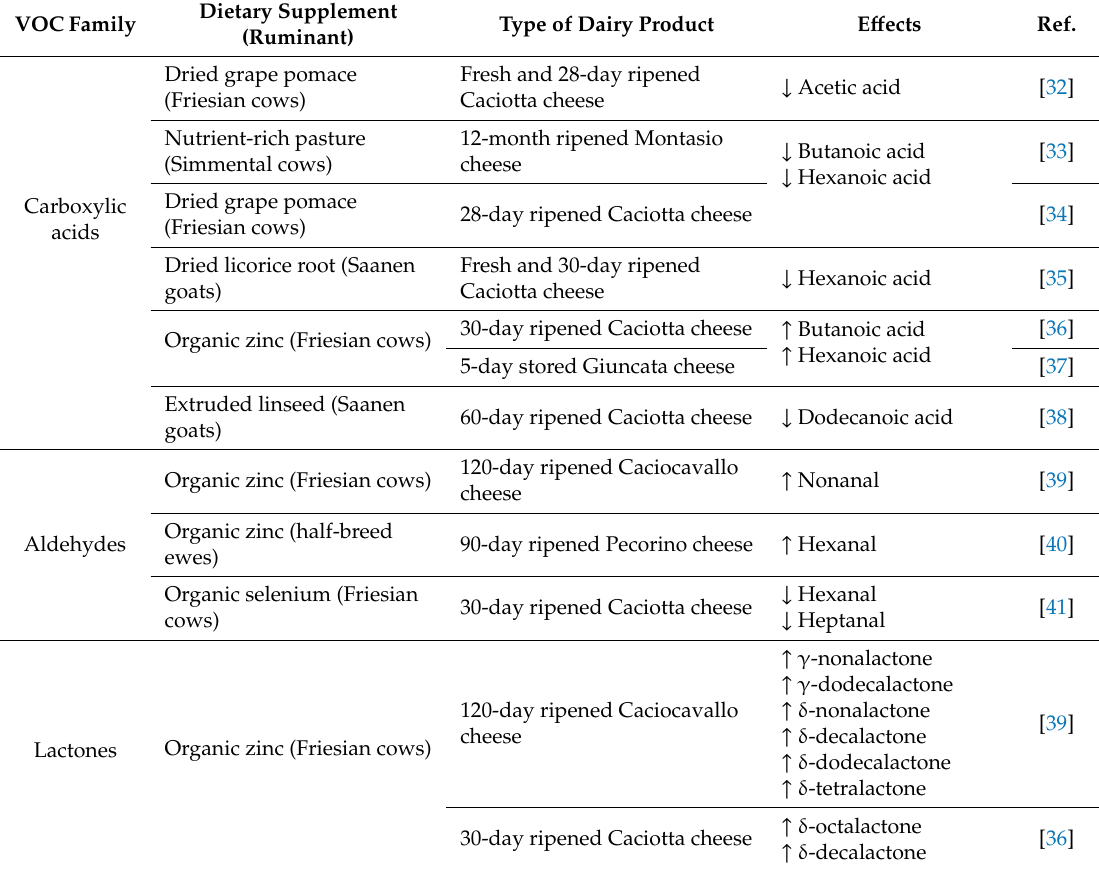
Table 1. Summary of the most relevant variations found in di ff erent dairy products obtained from ruminants fed experimental